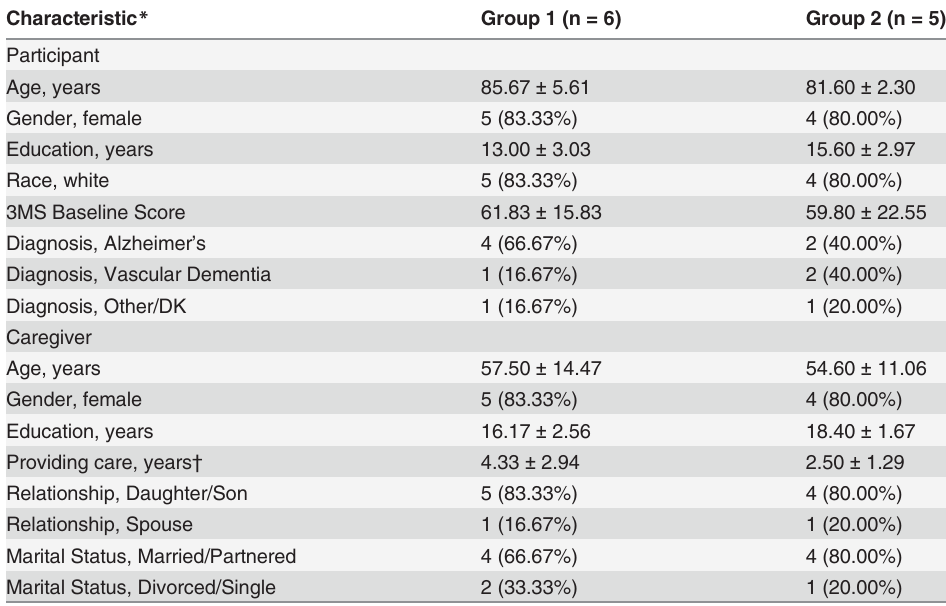
Table 2. Baseline